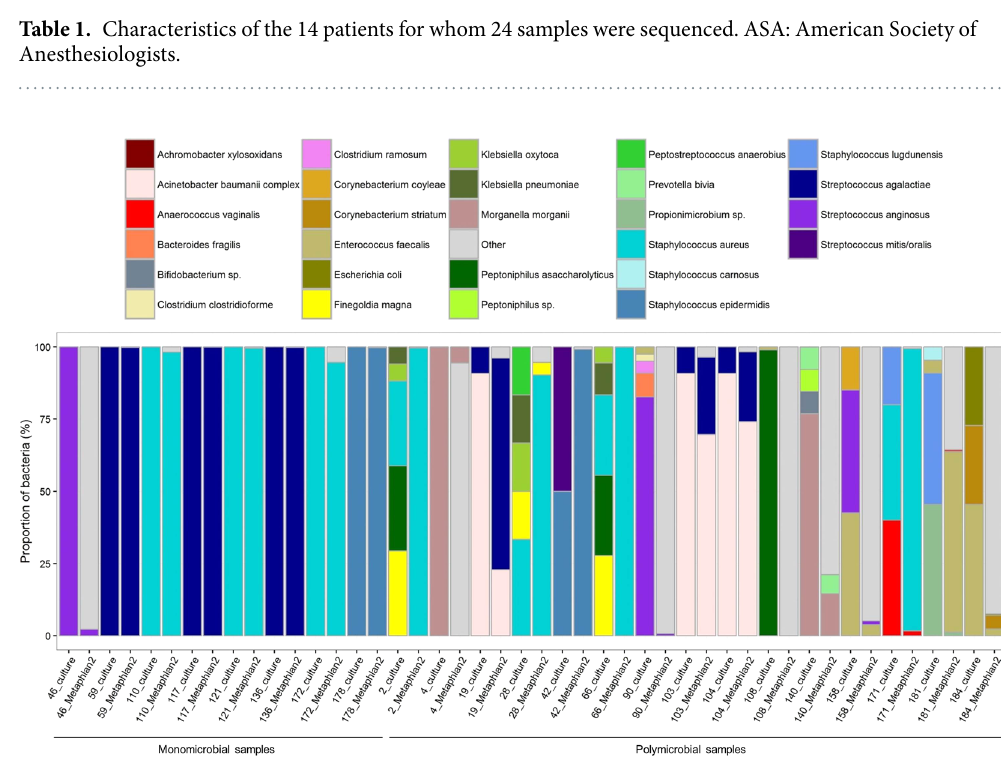
Figure 2. Proportions of the species recovered in culture and from reads (using MetaPhlAn2 24